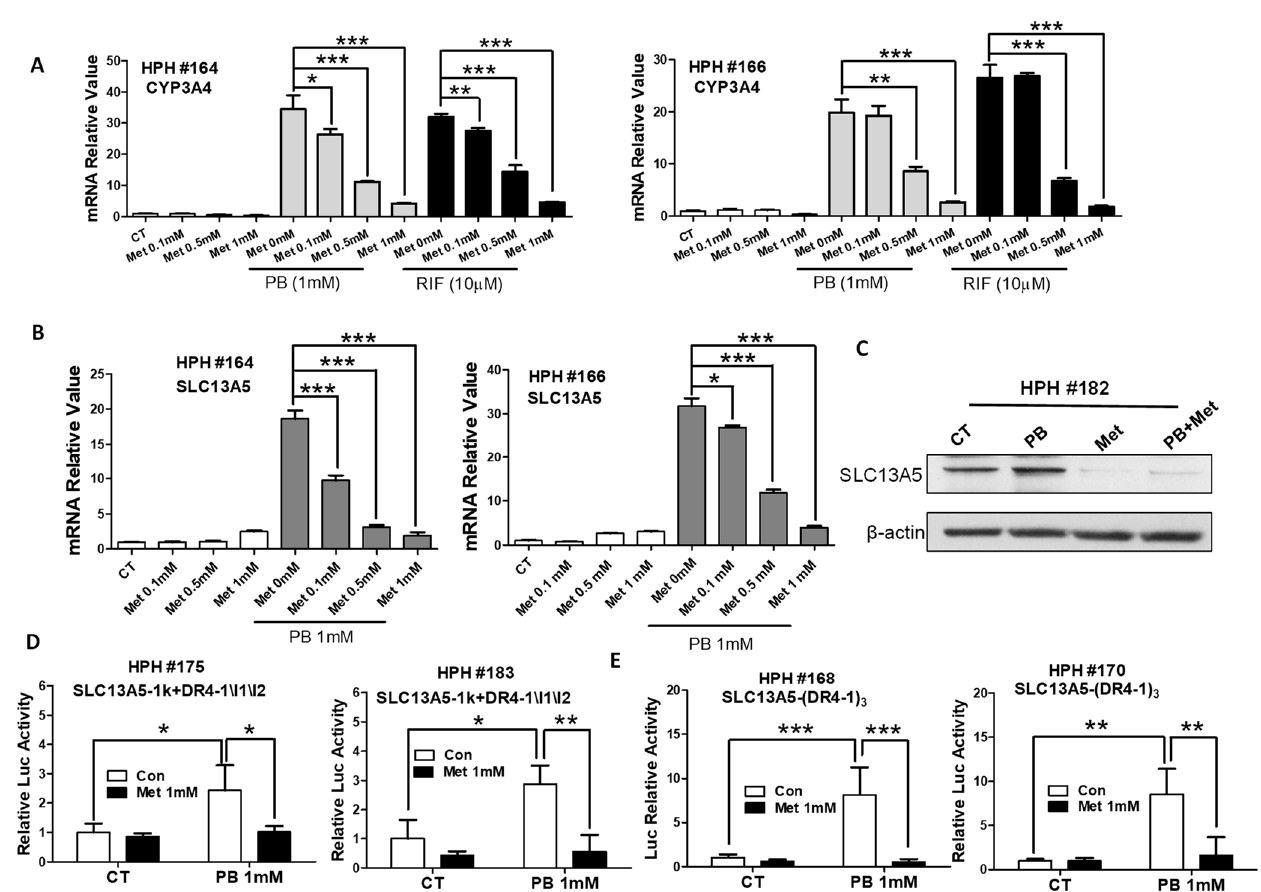
Figure 6. Metformin represses PB-mediated SLC13A5 expression by inhibition of PXR activation. HPH were treated with vehicle control (CT), PB (1 mM), Met (0.1, 0.5, 1 mM), or their combinations as indicated for 24 h. Total RNA extracted from hepatocytes was subjected to RT-PCR analysis of CYP3A4 and SLC13A5 expression ( A and B ). Homogenate proteins from CT, PB (1 mM), Met (1 mM), or PB + Met treatments were subjected to immunoblotting analysis of SLC13A5 and β -actin expression ( C ). HPH transfected with the SLC13A5-1k+DR4-1\I1\I2 ( D ) or SLC13A5-(DR4-1)3 ( E ) reporter construct as described in Materials and Methods were treated with CT, PB (1 mM) with and without Met (1 mM) for 24 h before the determination of luciferase activities. Data represent the mean ± S.D. ( n = 3), * p < 0.05; ** p < 0.01; *** p < 0.001.